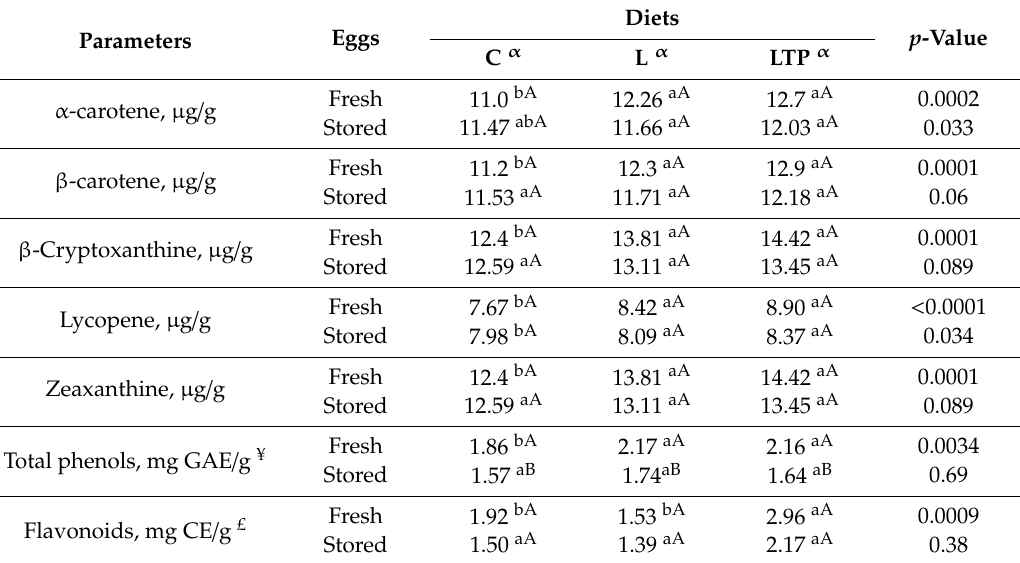
Table 3. Egg yolk antioxidants profile before and after storage at 4 ◦ C for one month.